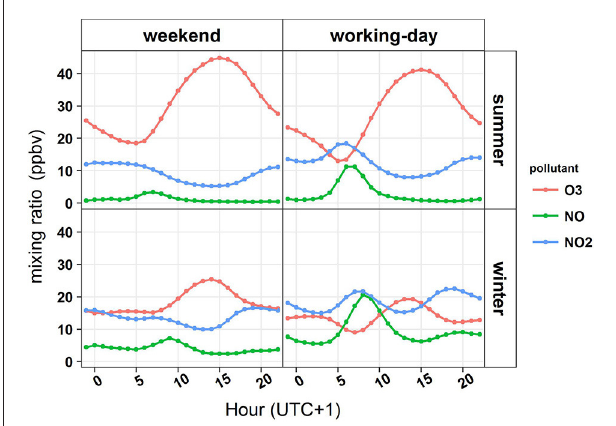
FIGURE 1 | Mean diurnal cycles of NO, NO 2 , and O 3 hourly mixing ratios during the summer and winter half year depending on traffic volume, averaged over the period 2005–2015 (in